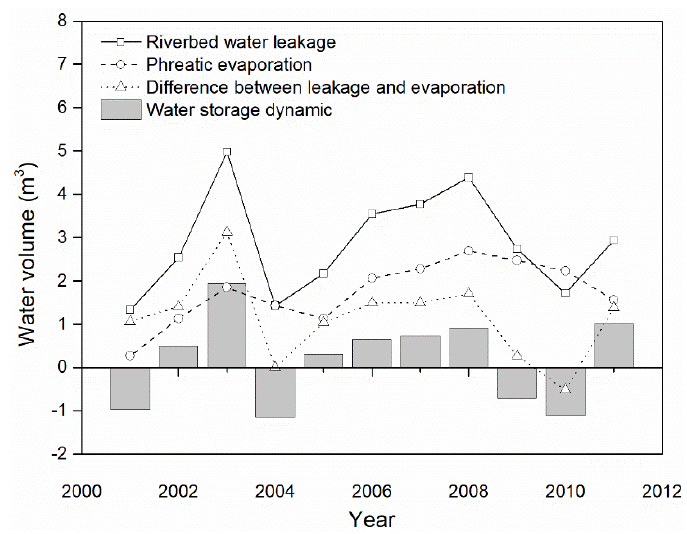
Figure 9. Water storage dynamics of the lower reach from 2001 to 2011.